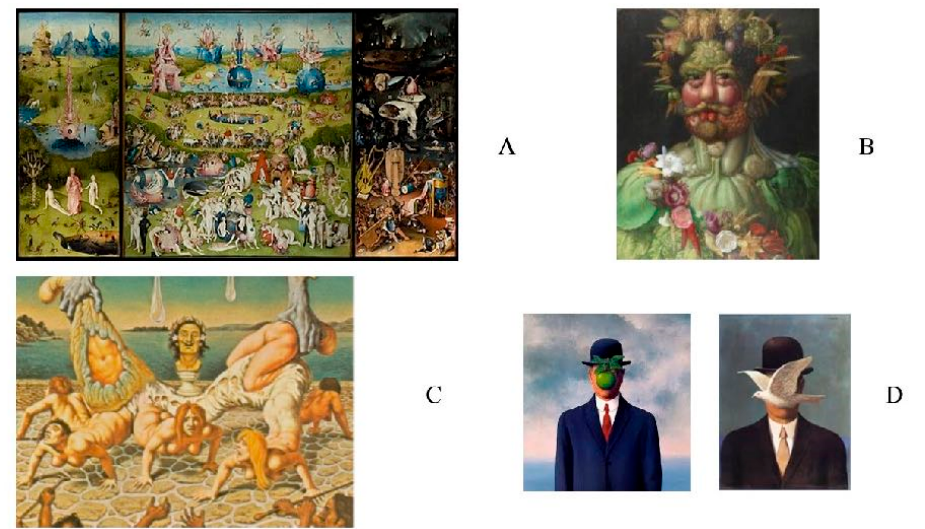
Figure 1. Mythological hybrid, wonderfully painted by Caravaggio in the Shield with Medusa head, oil on canvas, dating 1595–1598, Museo degli Uffizi in Florence, Italy. It takes inspiration from classical literature. Blood is flowing from the neck and eyes are horrified by Medusa’s self- viewing on Perseus’ bronze shield before being beheaded by her opponent. Not all artists of the past were as brutally frank as Caravaggio. In his Metamorphoses, Ovidius claims that Perseus is taken from pity toward his victim and puts Medusa’s head on a bed of algae, so that “anguiferum- que caput dura ne laedat harena” (i.e., ‘‘so that the hard sand will not injury the eel-covered head’’).